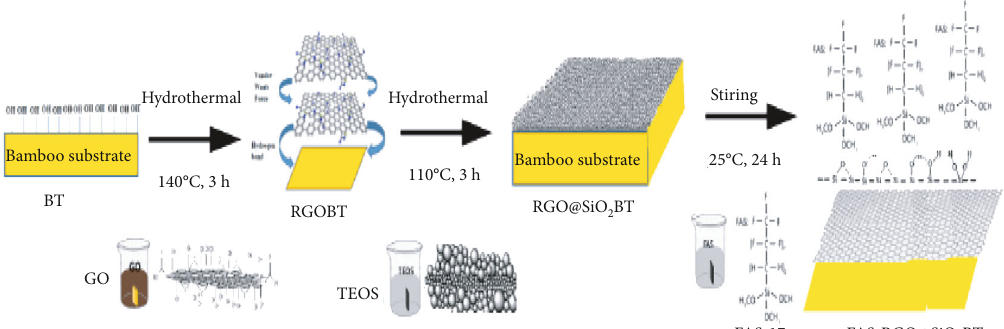
Figure 6: Schematic illustration and synthetic mechanism of FAS-RGO@SiO